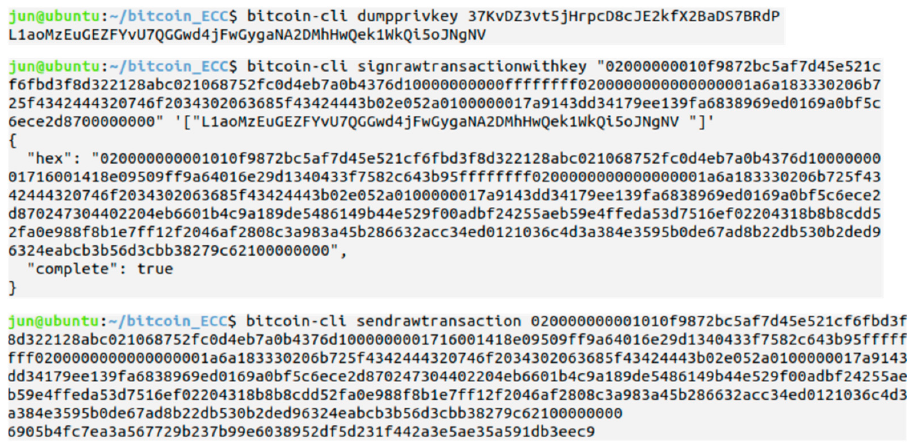
Figure 11. Sign and Send Raw Transaction in bitcoin.